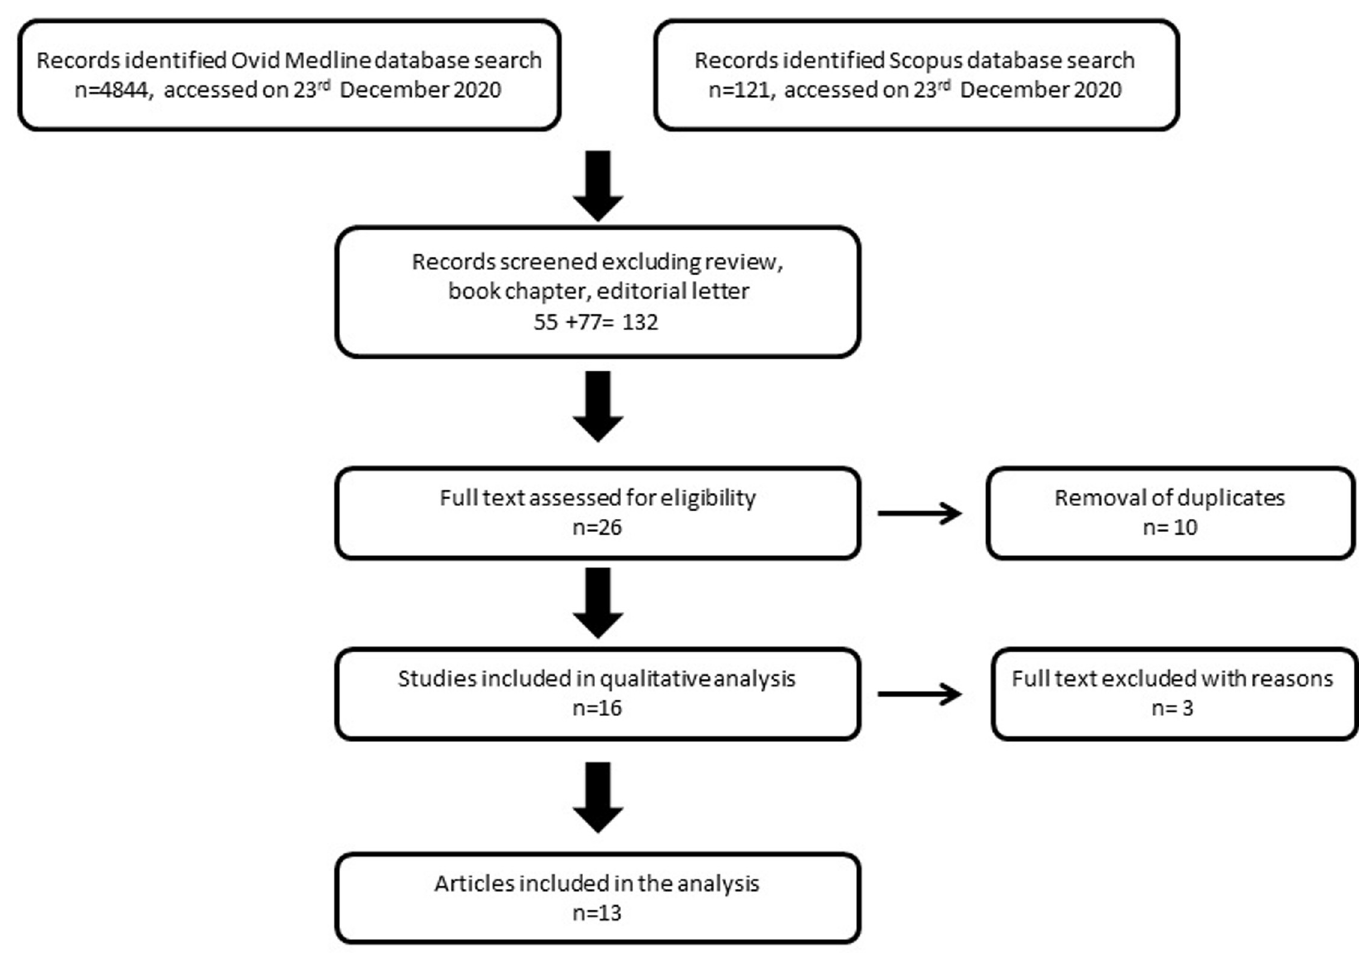
Fig 1. Flowchart of the selection